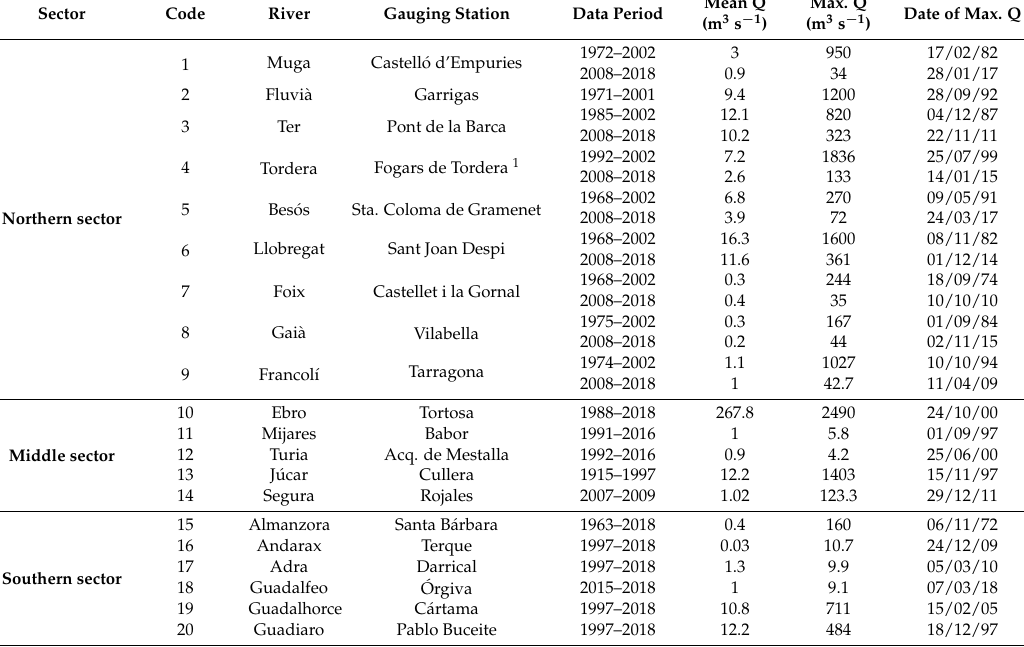
Table 4. Hydrological characteristics of the studied rivers. Modified and updated from